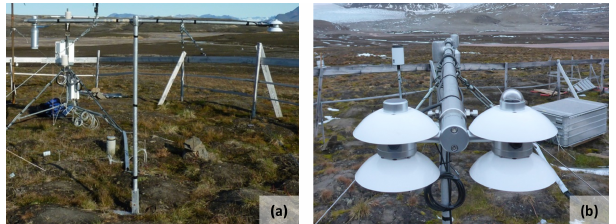
Figure C3. Climate station, Bayelva, October 2009–present (with sensor heights), (78.92094 ◦ N, 11.83334 ◦ E). (a) radiation–snow tower; (b) four-components radiation